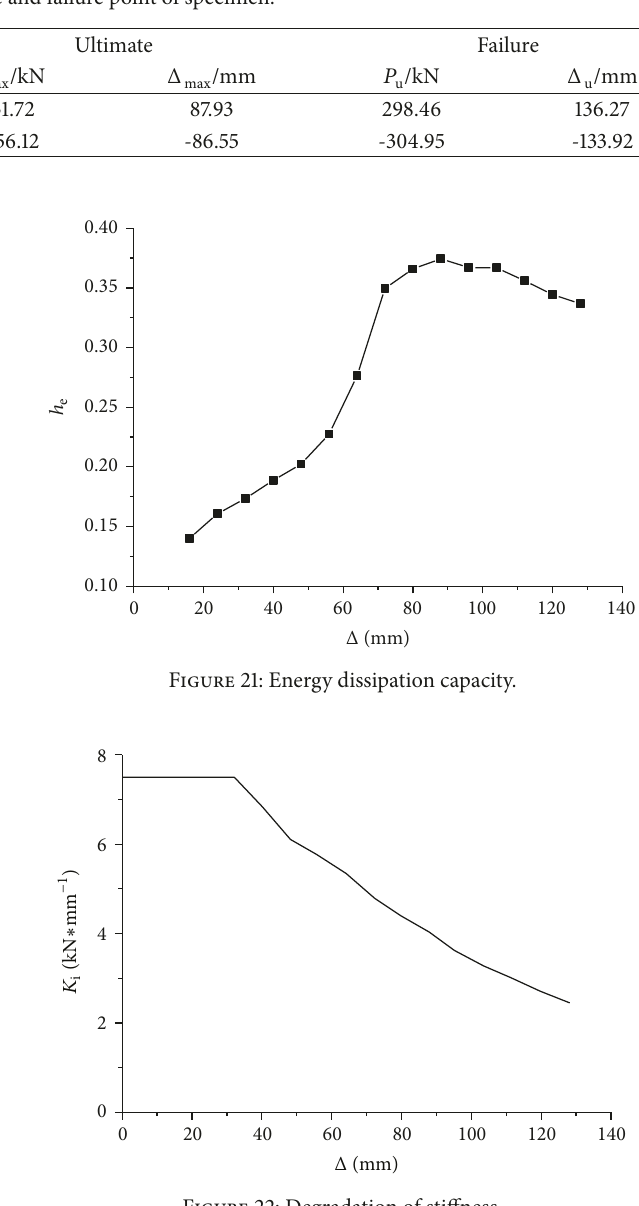
Figure 22: Degradation of